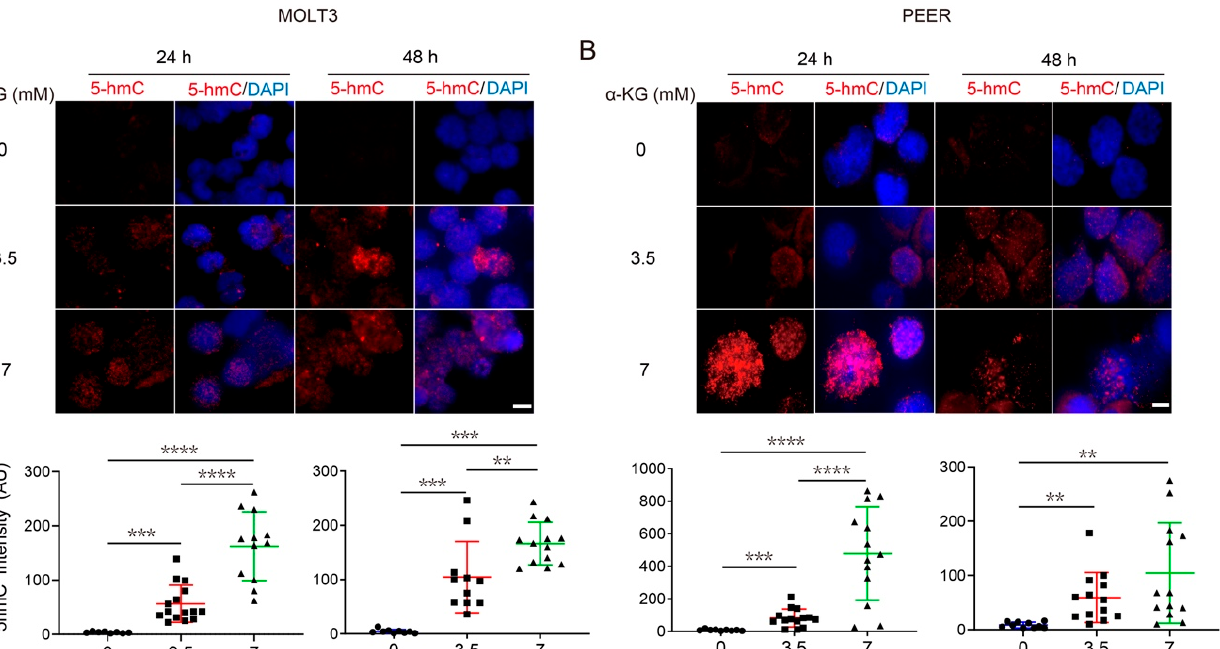
Figure 5. DLST inactivation significantly increases DNA demethylation in human T-ALL cells. ( A , B ) 5hmC staining in MOLT3 ( A ) and PEER ( B ) cells at 5 days after DLST knockdown, with Luciferase